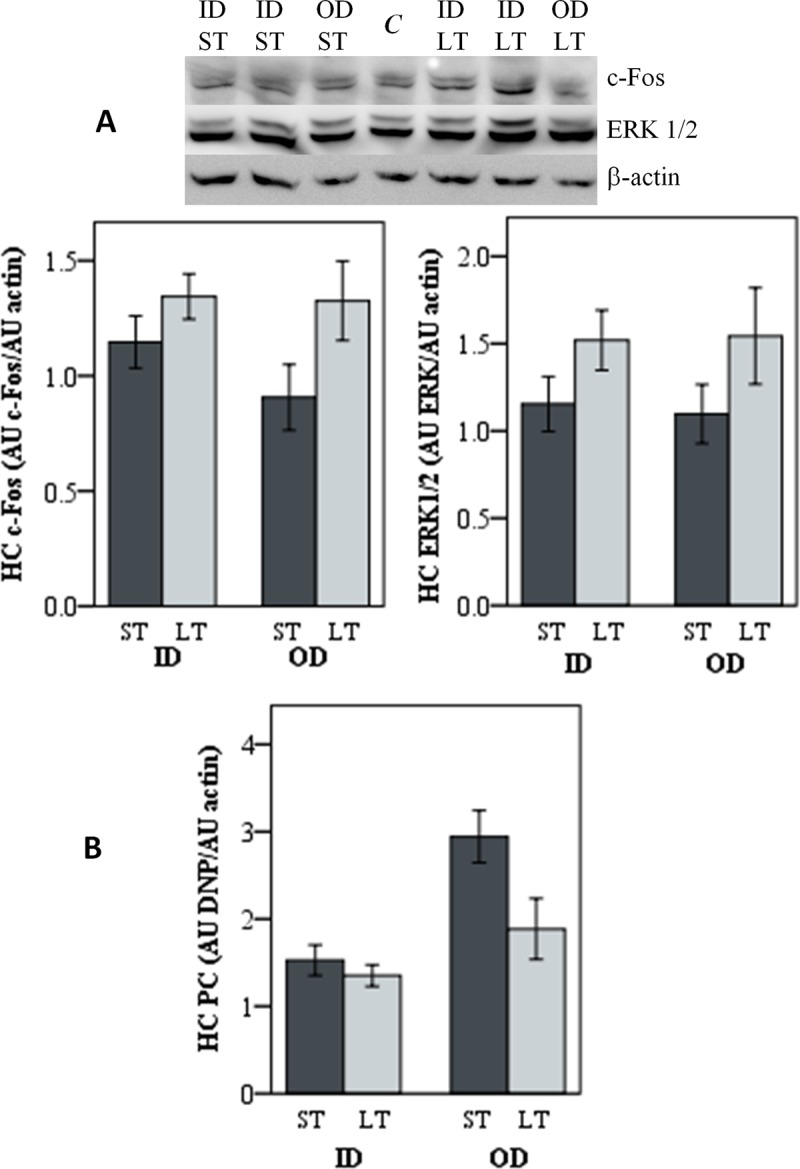
Molecular markers in the HC of pigs raised indoors (ID) or outdoors (OD) and transported to the slaughterhouse in low stress (LS) or in high stress (HS) conditions.(A) Representative Western blot of c-Fos and ERK1/2 and densitometry of all individual samples (n = 24). A sample brain was used as internal control (C) to allow inter-gel comparison. Actin was used as loading control. Results are presented as ratios of absorbance units (AU) of protein band to AU of β-actin. (B) Protein carbonylation (PC) represented as AU of DNP groups to AU of β-actin ratio. Data is shown as mean ± SE.